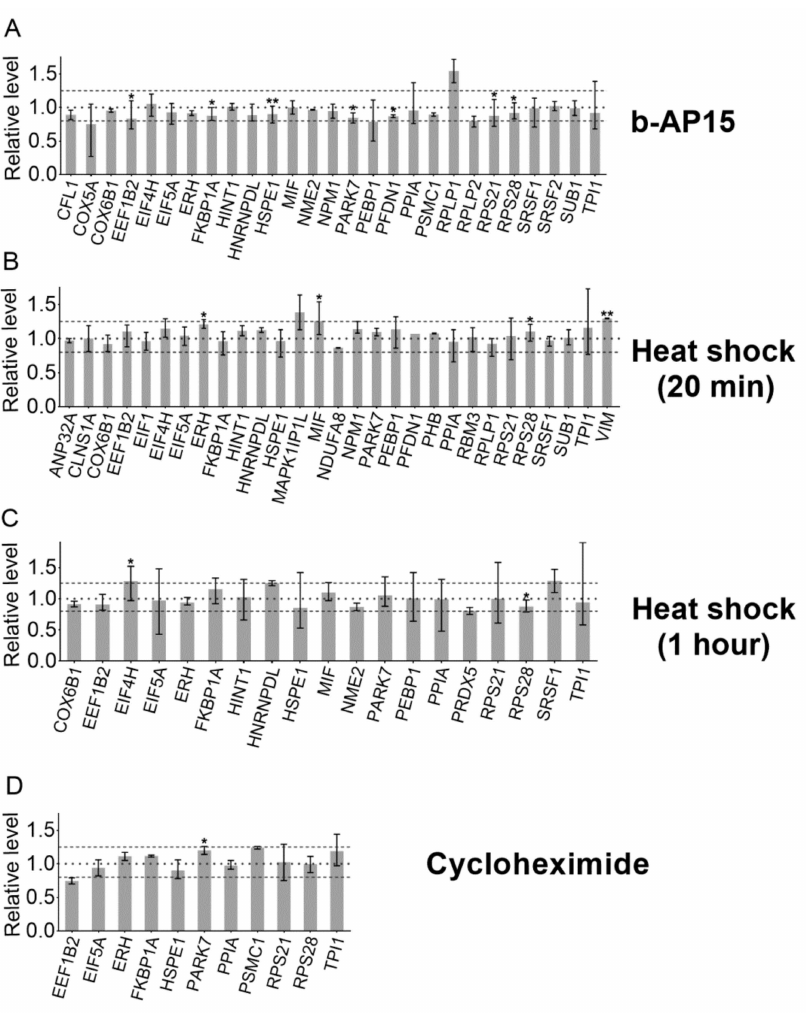
Figure 3. Mean relative levels of peptides from proteins in response to treatment with 1 µ M b-AP15 for 1 h ( A ), 42 ◦ C heat shock for 20 min ( B ) or 1 h ( C ), and 0.2 mM cycloheximide for 35 min ( D ). For all the proteins that gave rise to at least two peptides, the relative levels of all peptides (including di ff erent charge states and / or number of tags) derived from a single protein were averaged. Ratios of 0.8 and 1.25 are marked with dashed lines, and 1.0 is marked with a dotted line. Error bars indicate the range between the largest (upwards error bar) and smallest (downwards error bar) peptide ratio from each protein. * p < 0.05; ** p < 0.01. Mean relative levels of peptides derived from these proteins, statistical significance, and number of peptides from each protein are provided in Table